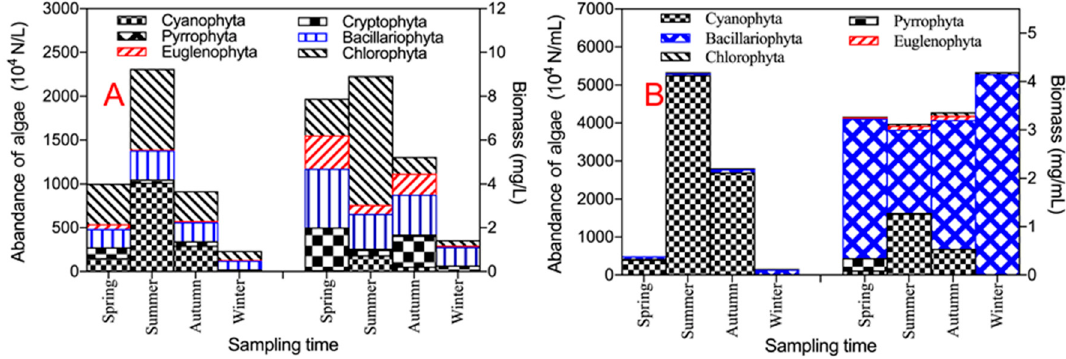
Figure 4. The seasonal changes of abundance and biomass of planktic ( A ) and epipelic algae ( B ). Notes: the left bars are the abundance of planktic algae expressed with left axis, and the right bars are the biomass of planktic algae expressed with right axis.